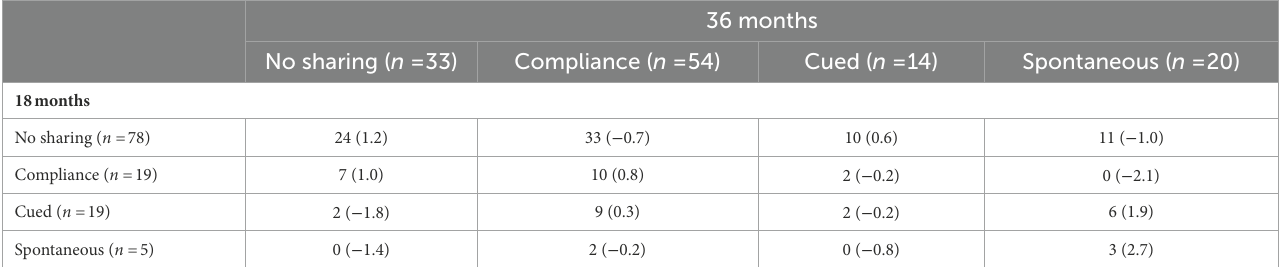
TABLE 6 Cross-tabulation of sharing stages at 18 and 36 months.